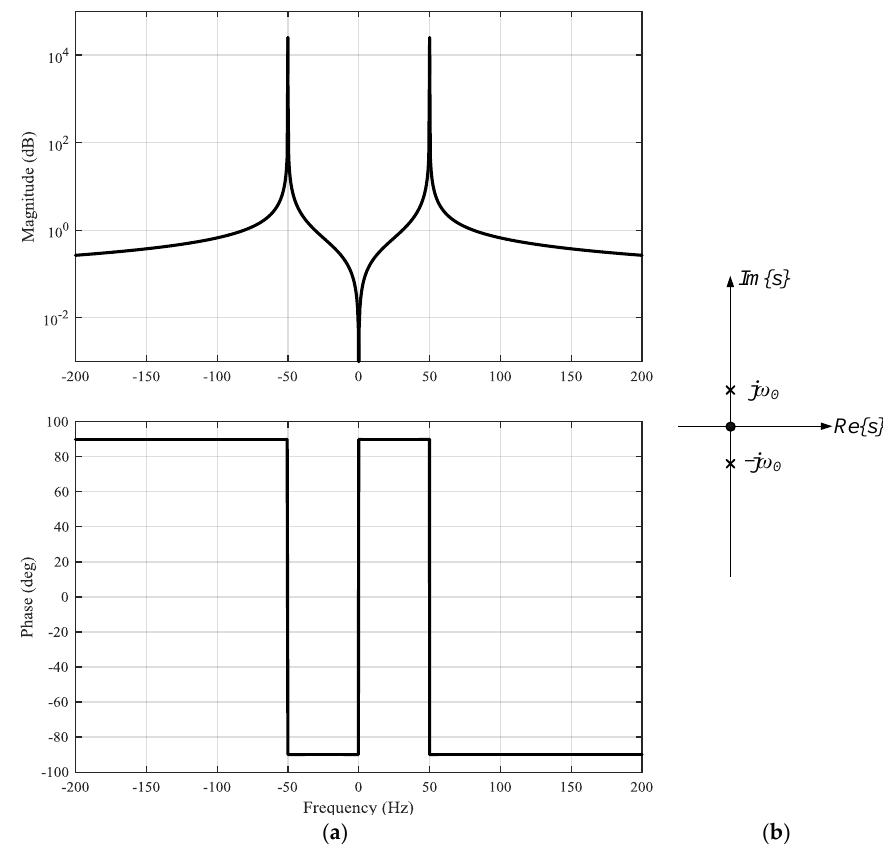
Figure 9. ( a ) Continuous time SOGI Bode diagram; ( b ) Continuous time SOGI pole-zero map.